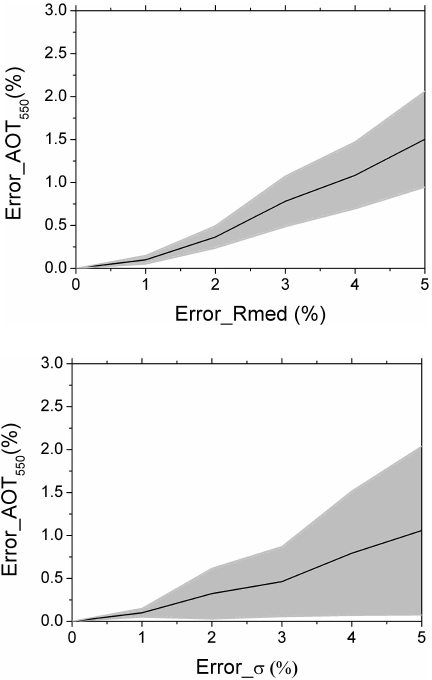
Fig. 4. Percent errors of the retrieved AOT as a function of the error within 1–5% for median radius and standard deviation for the size distribution function of Eq. (1) (geometrical inputs are θ 0 =60 ◦ , θ S =0 ◦ , and ϕ =0 ◦ ). The shaded area indicates ± σ . The valid range of AOT 550 is